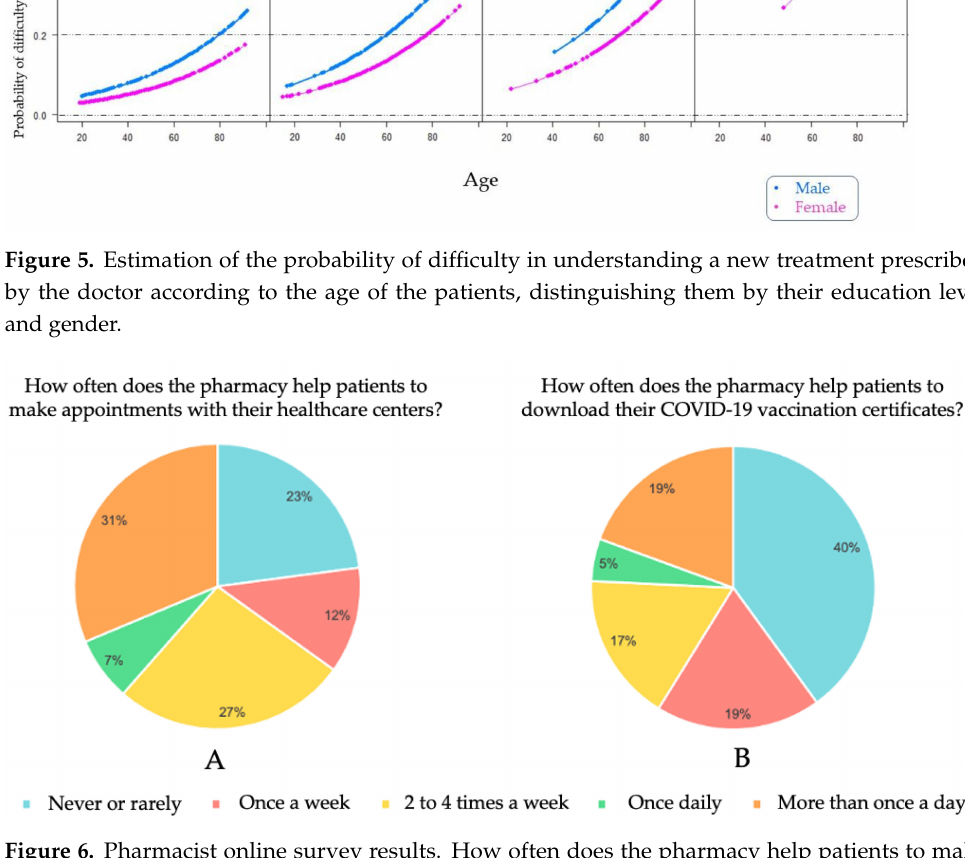
Figure 6. Pharmacist online survey results. How often does the pharmacy help patients to make an appointments with their healthcare centers ( A ) and to download their COVID-19 vaccination certificates ( B